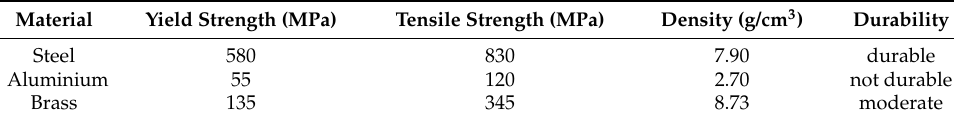
Table 4. Comparison of material properties.